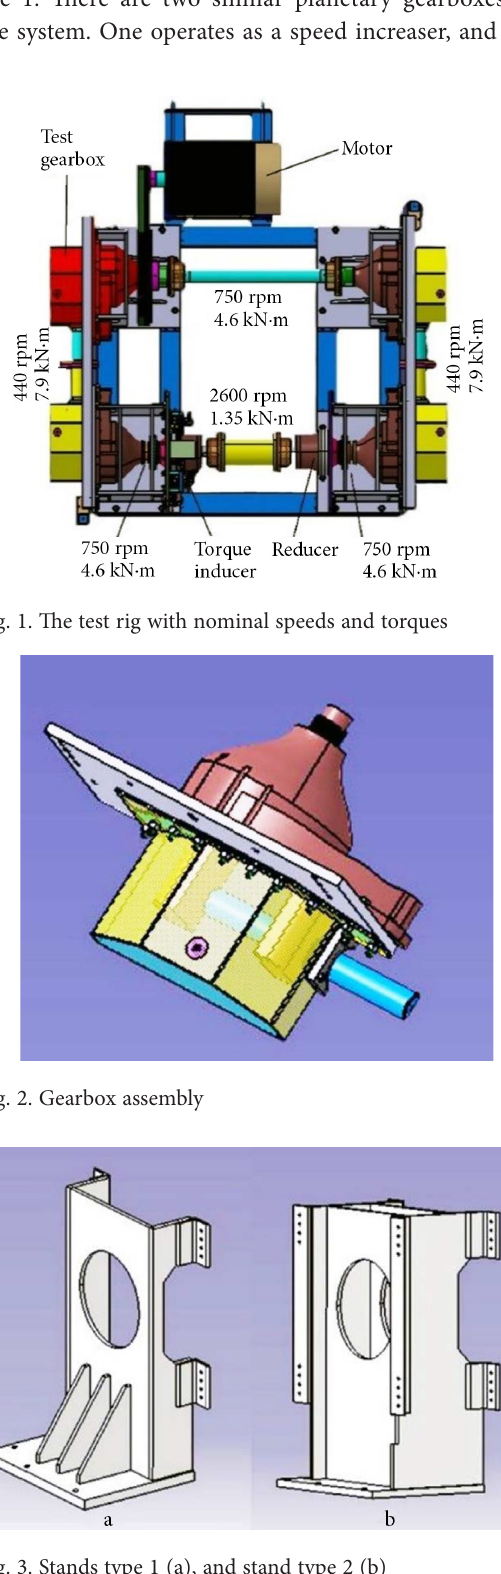
Fig. 3. Stands type 1 (a), and stand type 2